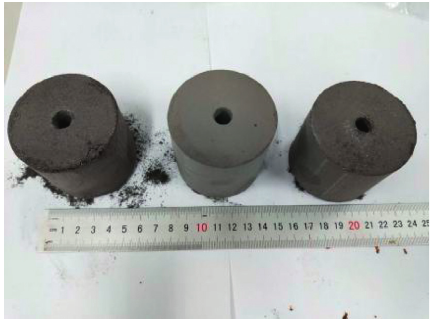
Figure 2: Oxygen candle test